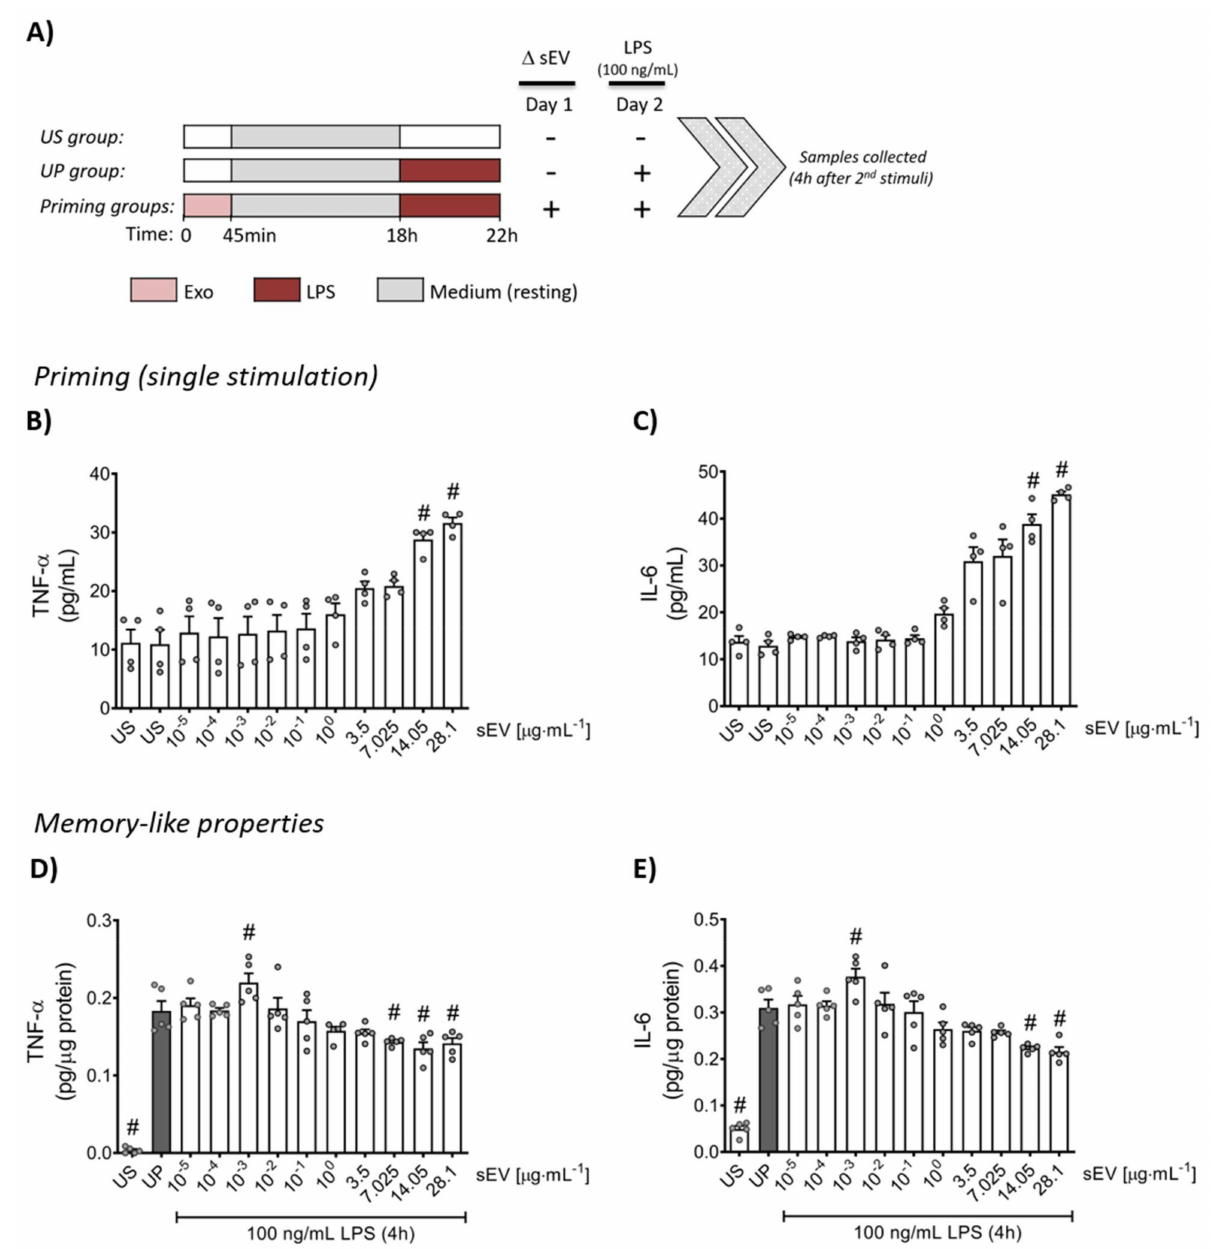
Figure 2. Cytokine responses with increasing concentrations of small EVs. ( A ) Bone marrow neu- trophils were primed in a protein concentration-dependent manner with microbiota-derived small EVs (( B , C ); n = 4) for 45 min and later after resting using the two-step protocol, re-challenged by 100 ng/mL LPS for 4 h expressing adaptive manners (( D , E ); n = 5; normalized to total protein concen- tration). The cytokine production of TNF- α and IL-6 was measured using ELISA. Data are presented as scatter dot plots, mean + SEM, # p < 0.05, # versus unstimulated state (US) ( B , C ); # p < 0.05, # versus unprimed state (UP, gray bar) ( D , E